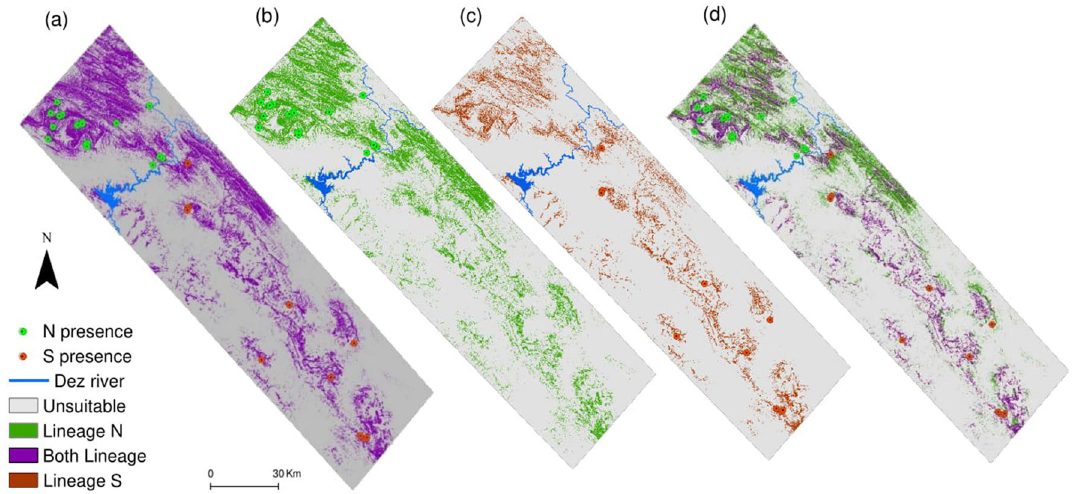
Figure 3. Potentially suitable areas according to ( a ) Species-level binary model, ( b ) N lineage binary model, ( c ) S lineage binary model and ( d ) overlay of binary models of the two lineages (N + S binary model) for Neurergus kaiseri at the local scale. The Dez River is depicted as a reference for lineages distribution.